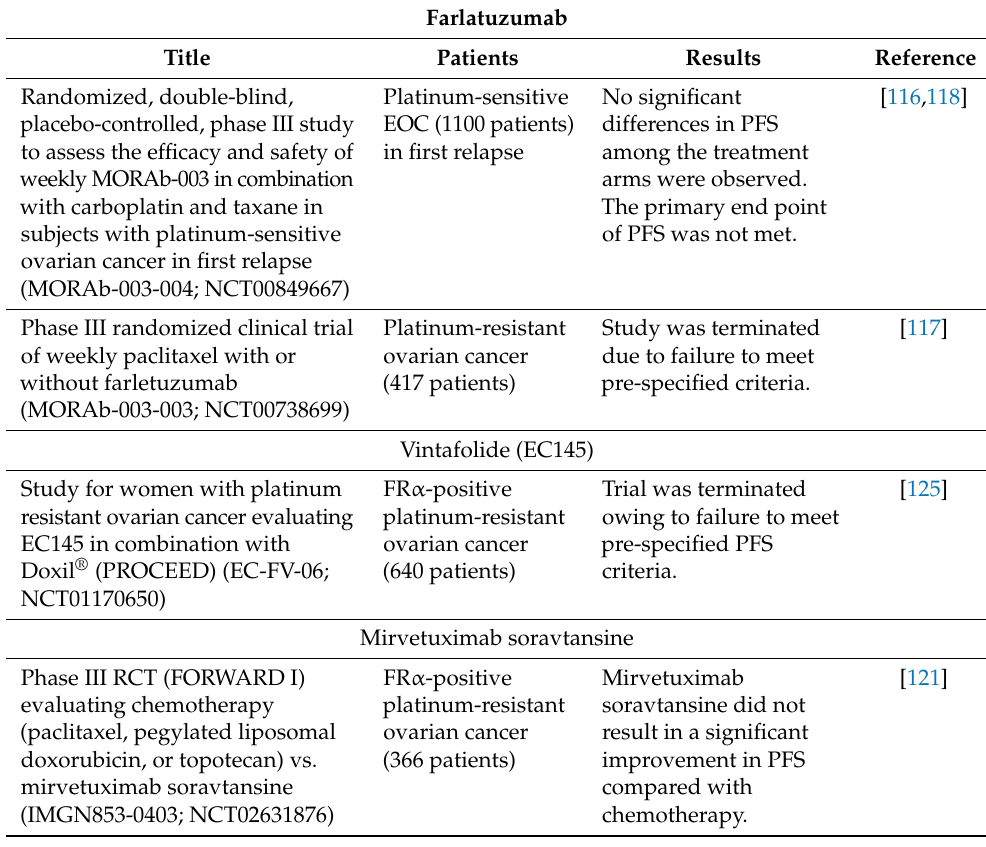
Table 1. Phase III clinical trial involving FR α -targeted therapies.